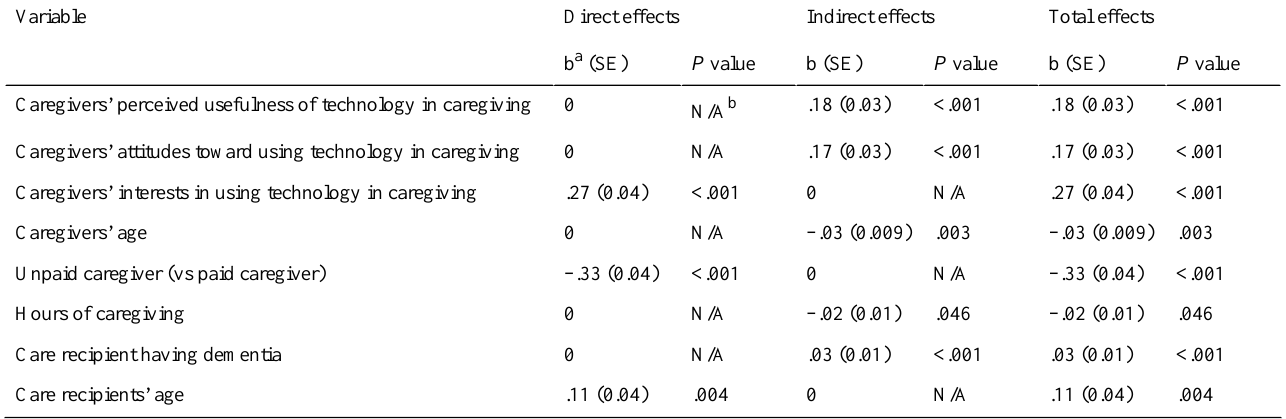
Table 2. Direct, indirect, and total effects of each predictor on care recipient’s use of fall alert